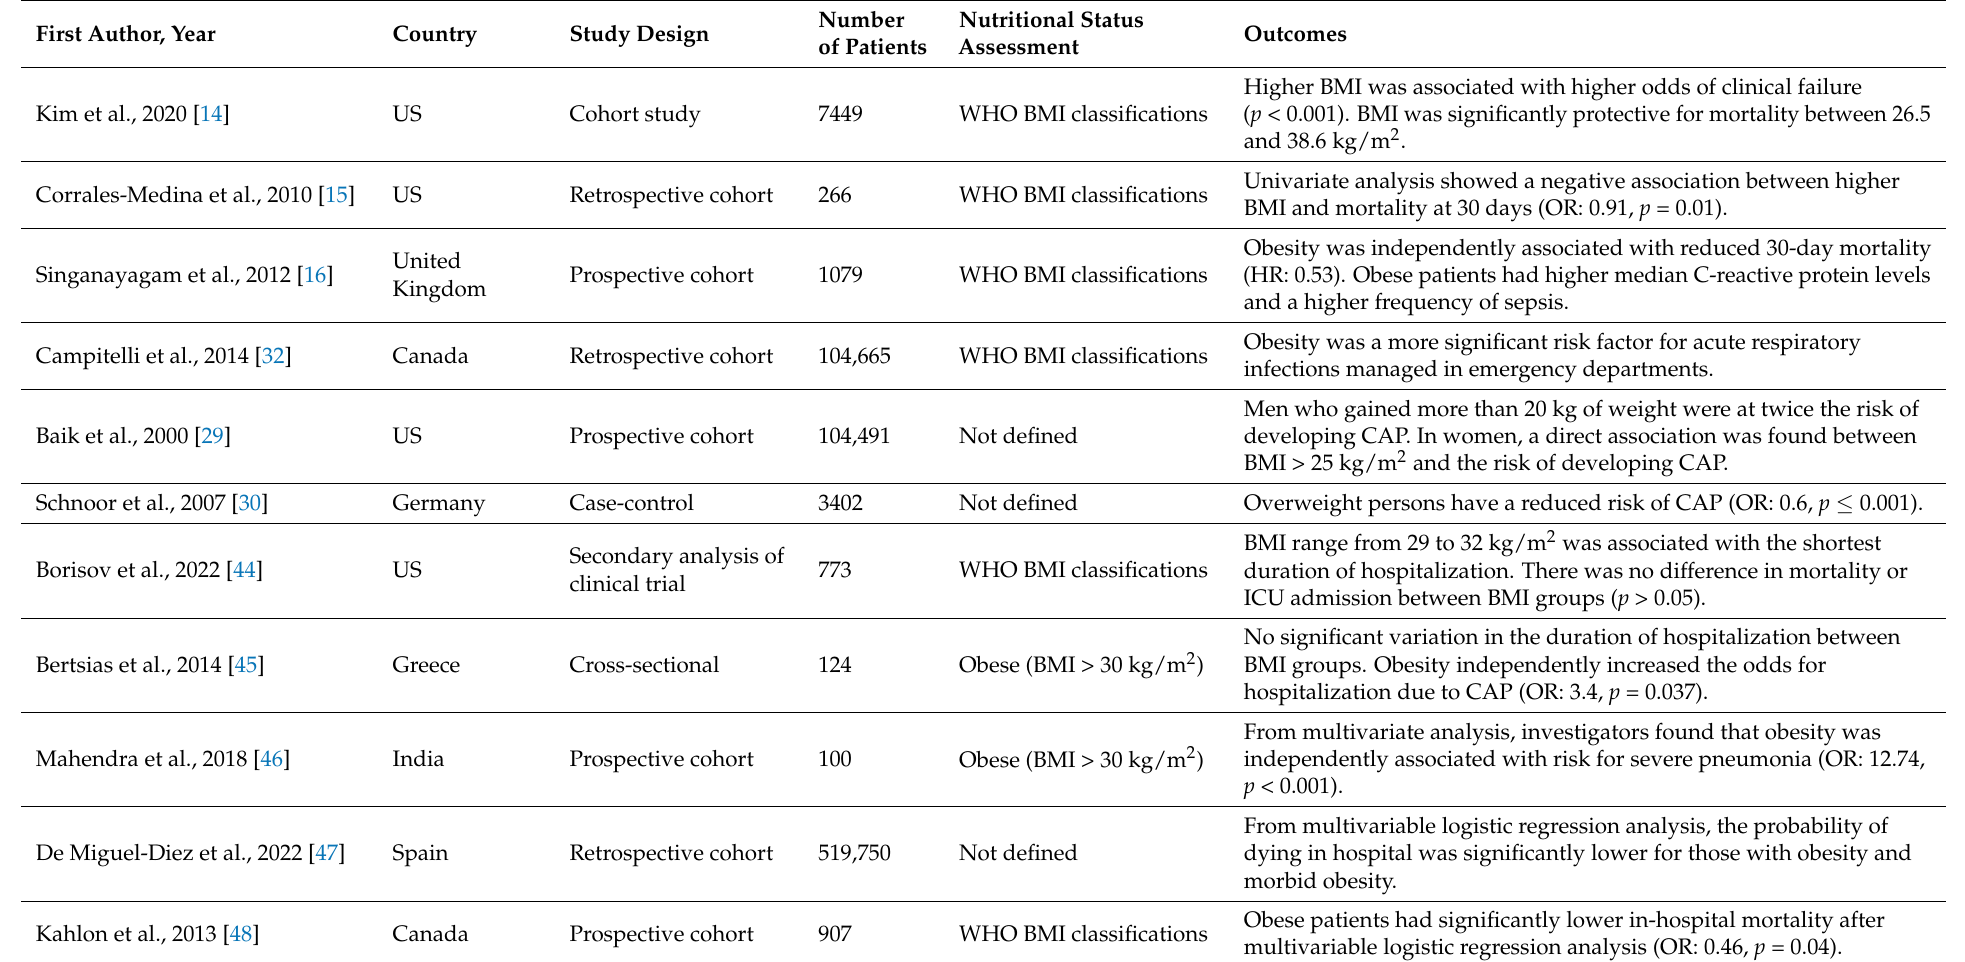
Table 2. Summary of studies on prognosis of CAP and